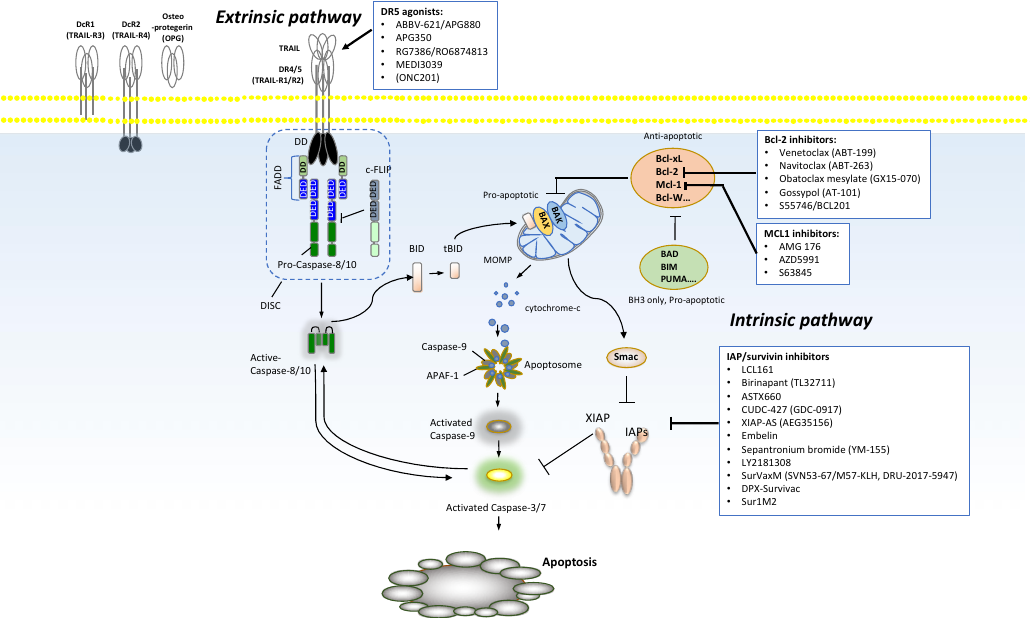
Figure 1. Two major apoptotic pathways.